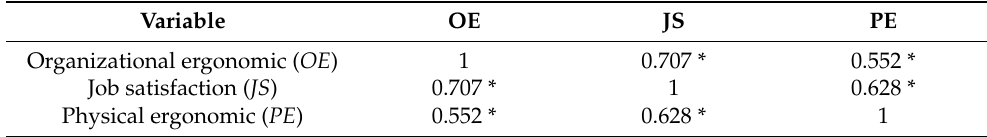
Table 10. Pearson correlation coefficient calculation concerning the constructs based on the sample (75